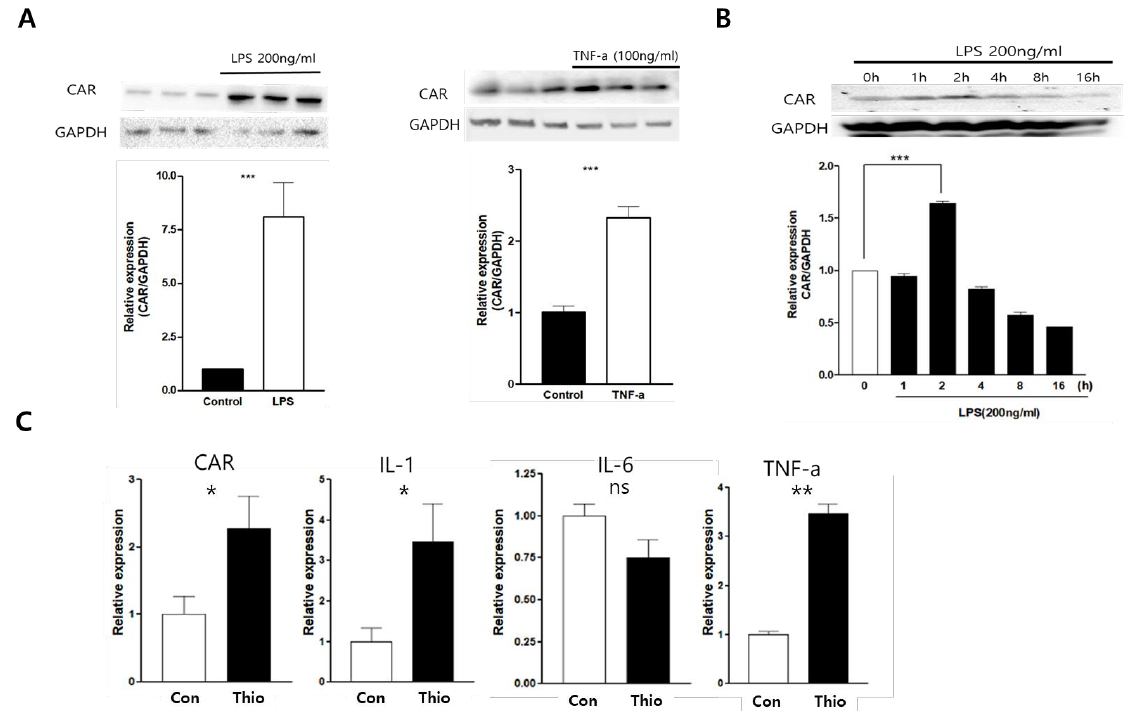
Figure 1. CAR expression was increased in LPS and TNF- α -stimulated macrophages. The Raw264.7 murine macrophage cell line was stimulated by LPS (200 ng/mL) and TNF- α (100 ng/mL) for 24 h, and protein and RNA were extracted. ( A ) Protein was subjected to western blot analysis using the indicated antibodies. ( B ) CAR bands indicate fold changes in CAR, which was normalized to GAPDH bands. A time-dependent change in CAR expression was shown, and the fold changes in CAR were normalized to GAPDH. ( C ) A thioglycollate-induced peritonitis mice model was generated, and the peritoneal macrophage cell (PMC) was isolated. The animal experiment was repeated three times. CAR, IL-1b, IL-6, and TNF-a mRNA levels were confirmed by real-time PCR. All data are expressed as the mean ± SEM from three independent experiments. NS, not significant, * p < 0.05, ** p < 0.01 and *** p < 0.001 according to a two- tailed Student’s t -test.